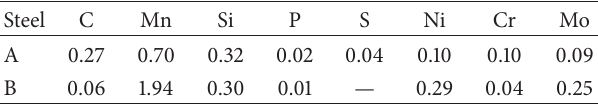
Table 1: Chemical composition of